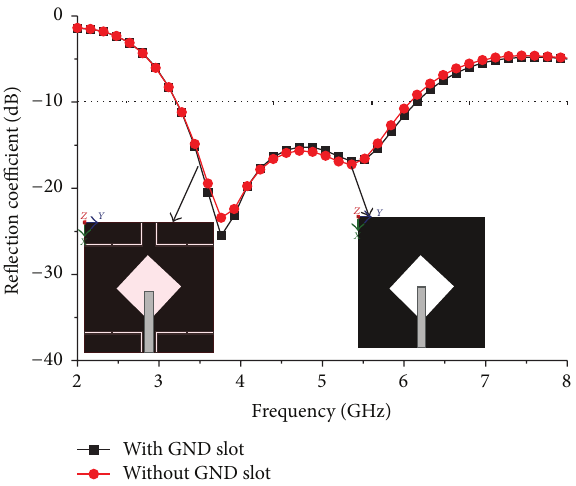
Figure 6: Effect of reflection coefficient for different values of 𝐿𝑓 . Table 1: Proposed antenna specification.